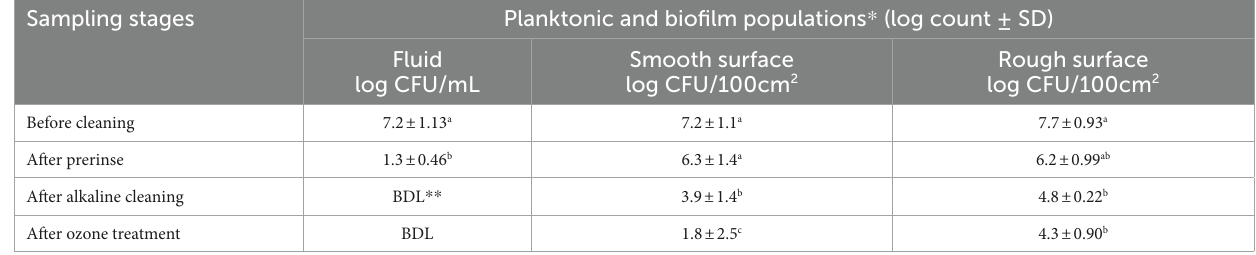
TABLE 1 Pseudomonas fluorescens ATCC 25289 populations recovered from the CIP system that was contaminated with 10% skim milk, inoculated with 0.5% culture, and held for 2 days, followed by circulating 10% skim milk for 5 days. The biofilm was subjected to water prerinse, alkaline cleaning (0.2% for 2 min), water post-rinse, and ozone treatment (5 ppm for 5 min) . Population counts were determined in fluid samples (for planktonic cells) and swab samples (for biofilm cells); the latter were taken from smooth and rough surfaces at different stages of cleaning and sanitization.